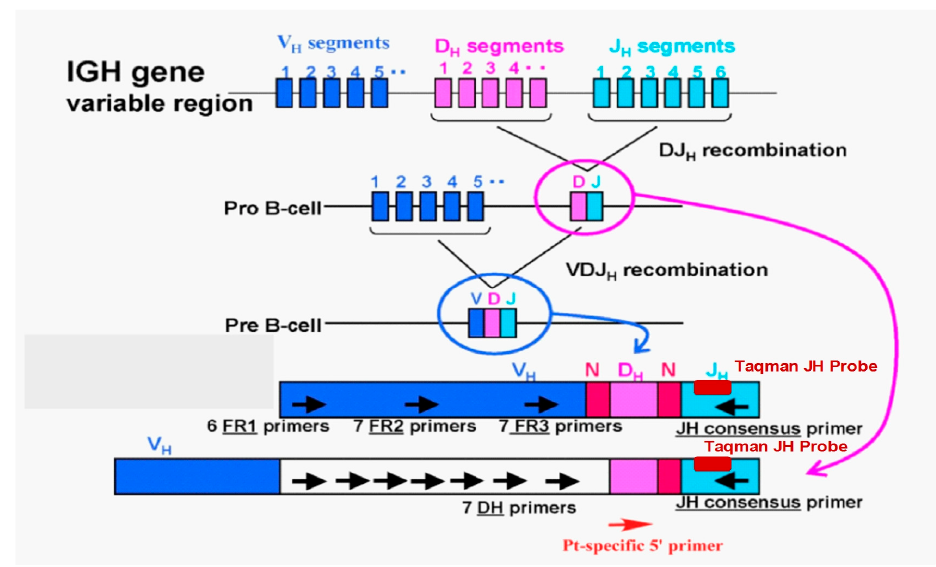
Figure 2. Allele-specific oligonucleotide-quantitative PCR (ASO-qPCR) method to detect minimal residual disease (MRD), and design of ASO-qPCR primers and probes.